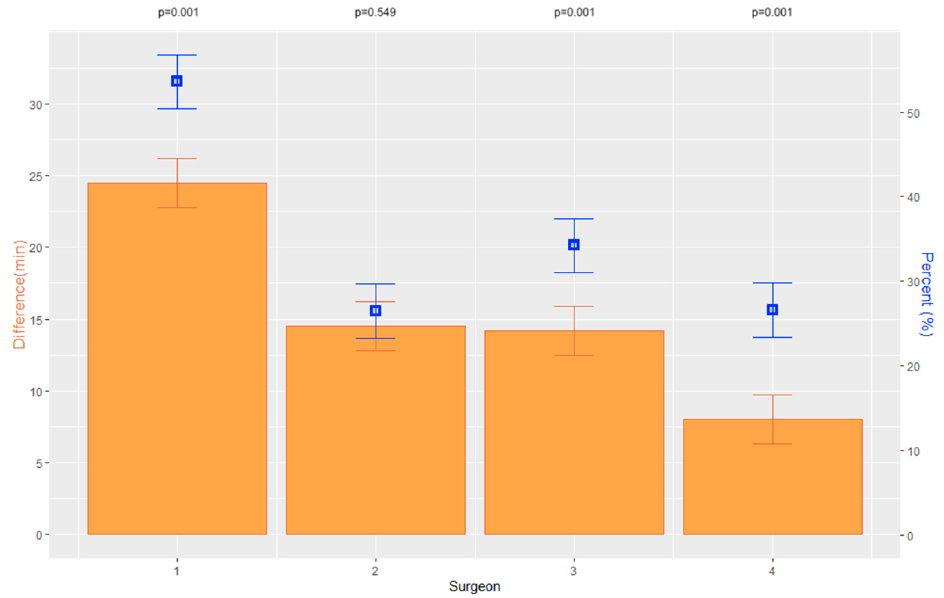
Figure 2. Graphs displaying absolute difference of surgical duration of DMEK of each surgeon between period 1 and 2 in minutes, including the standard error and p -values as well as the percentage difference for each surgeon. Table 2. Surgical data.